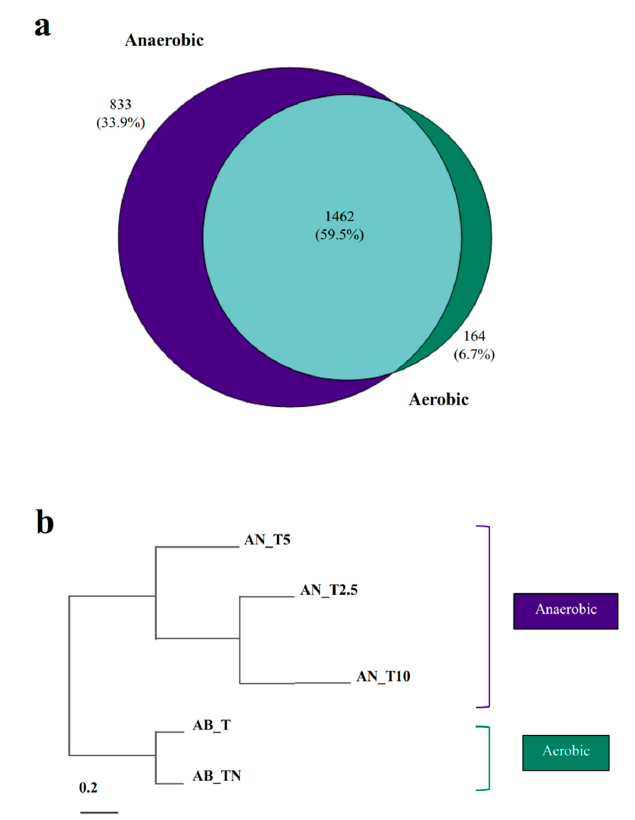
Figure 3. Proteome changes in response to oxygen and nitrate. Total and shared proteins ( a ) and hierarchical clustering of proteome profiles ( b ) among oxic and anoxic conditions with different nitrate concentrations are shown. AN_T represents cultures growing anaerobically with toluene and either 2.5 mM (AN_T2.5), 5 mM (AN_T5), or 10 mM (AN_T10) of KNO 3. AB_T represents cultures growing aerobically with benzoate and supplied additionally with either toluene alone (AB_T) or toluene and 5 mM of KNO 3 (AB_TN).